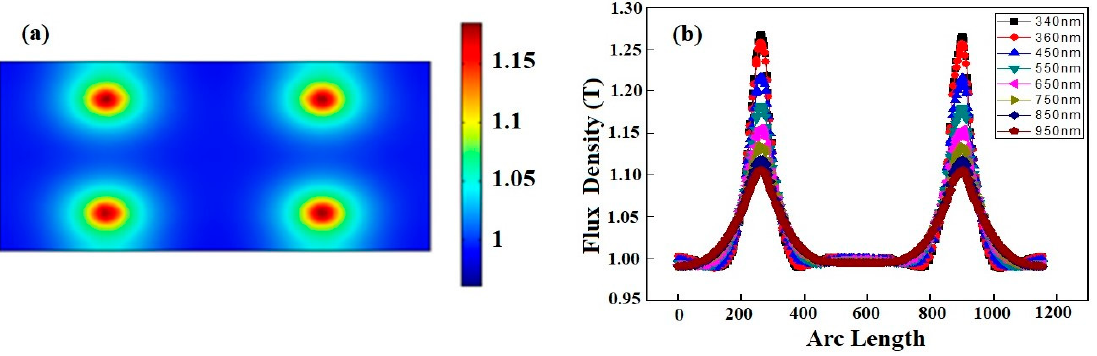
Figure 5. ( a ) Plasmons formed by shining the 340 nm light of on four GaN nanowires placed at some distance. The color bar showing flux density at different positions is given. ( b ) Flux density as a function of arc length showing plasmon formation by shining 340 nm on four GaN nanowires.